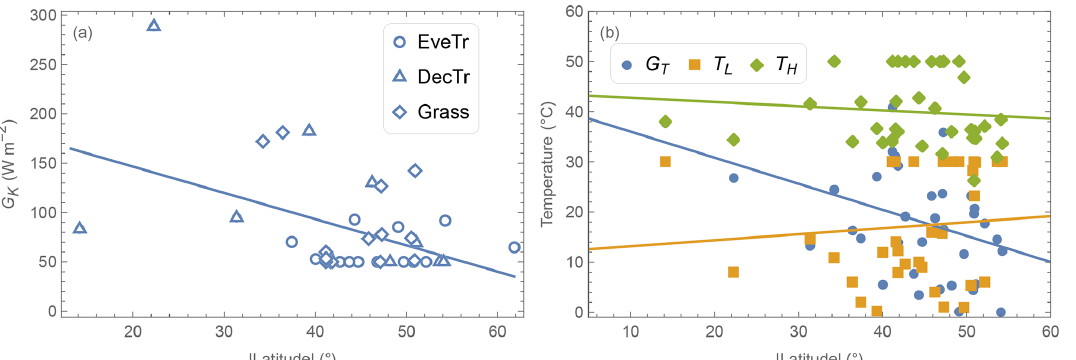
Figure 11. Relations between absolute latitude and derived parameters: (a) solar-radiation-related G K by PFT (symbol) and (b) temperature- related G T , T L and T H . Lines are derived by ordinary linear regression. See text for notation